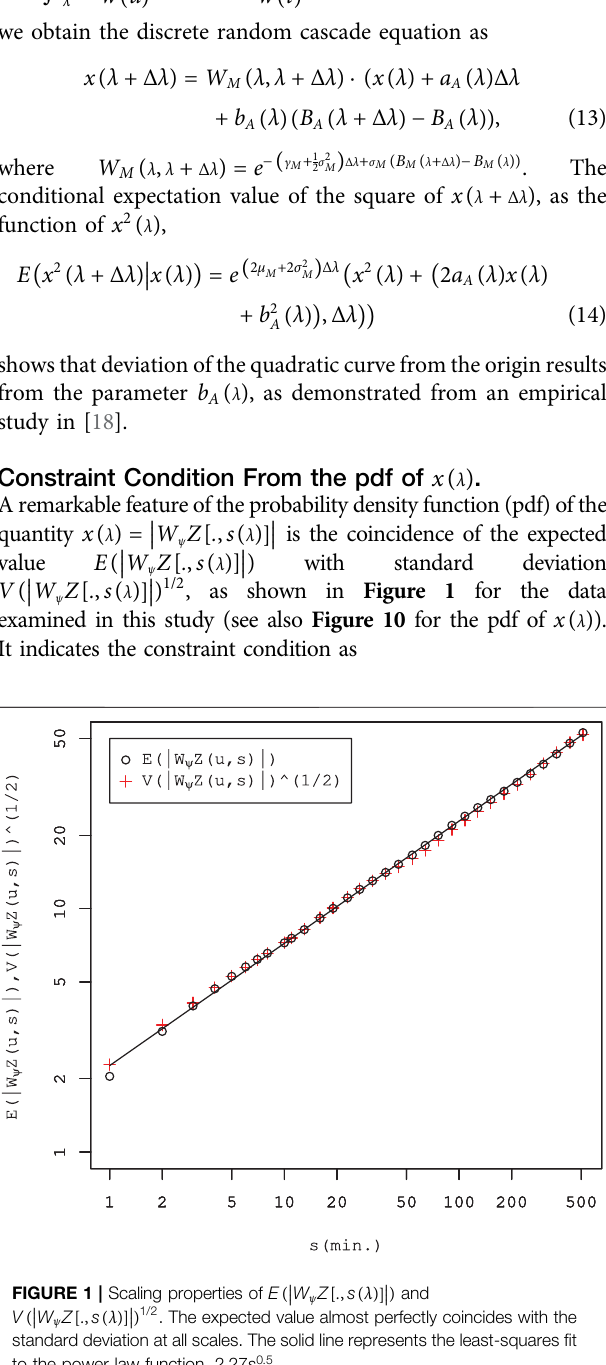
(cid:7)(cid:7)(cid:7)(cid:7) (cid:7)(cid:7)(cid:7)(cid:7) ) and W ψ Z [ ., s ( λ )]